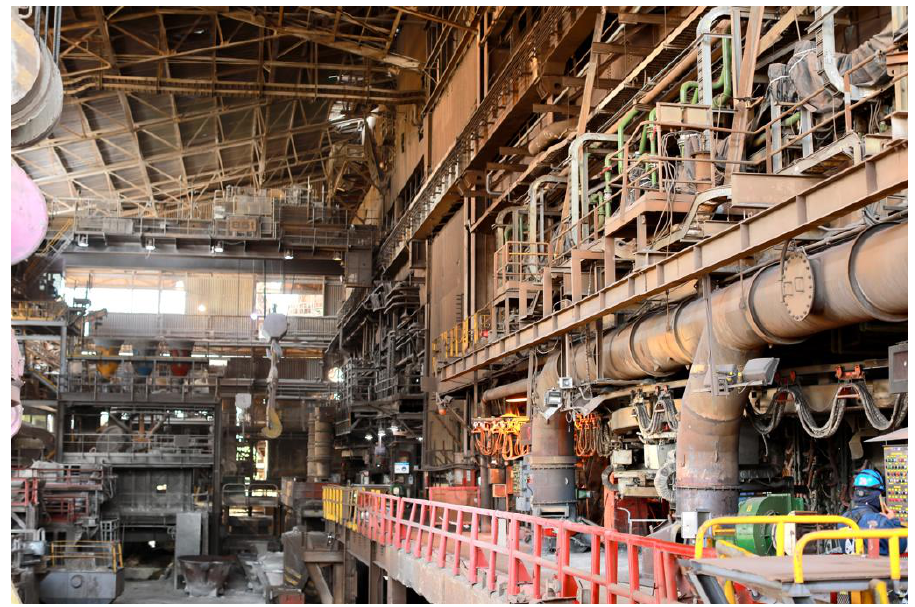
Figure 1. Panoramic of the CMSA